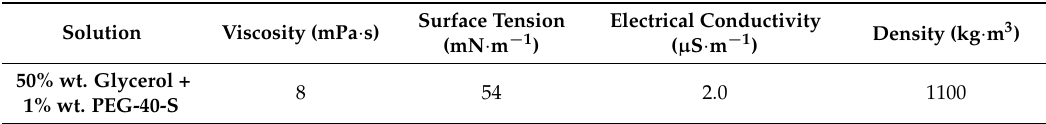
Table 1. Characteristic properties of the solution used in the experiment. PEG-40-S—polyethylene